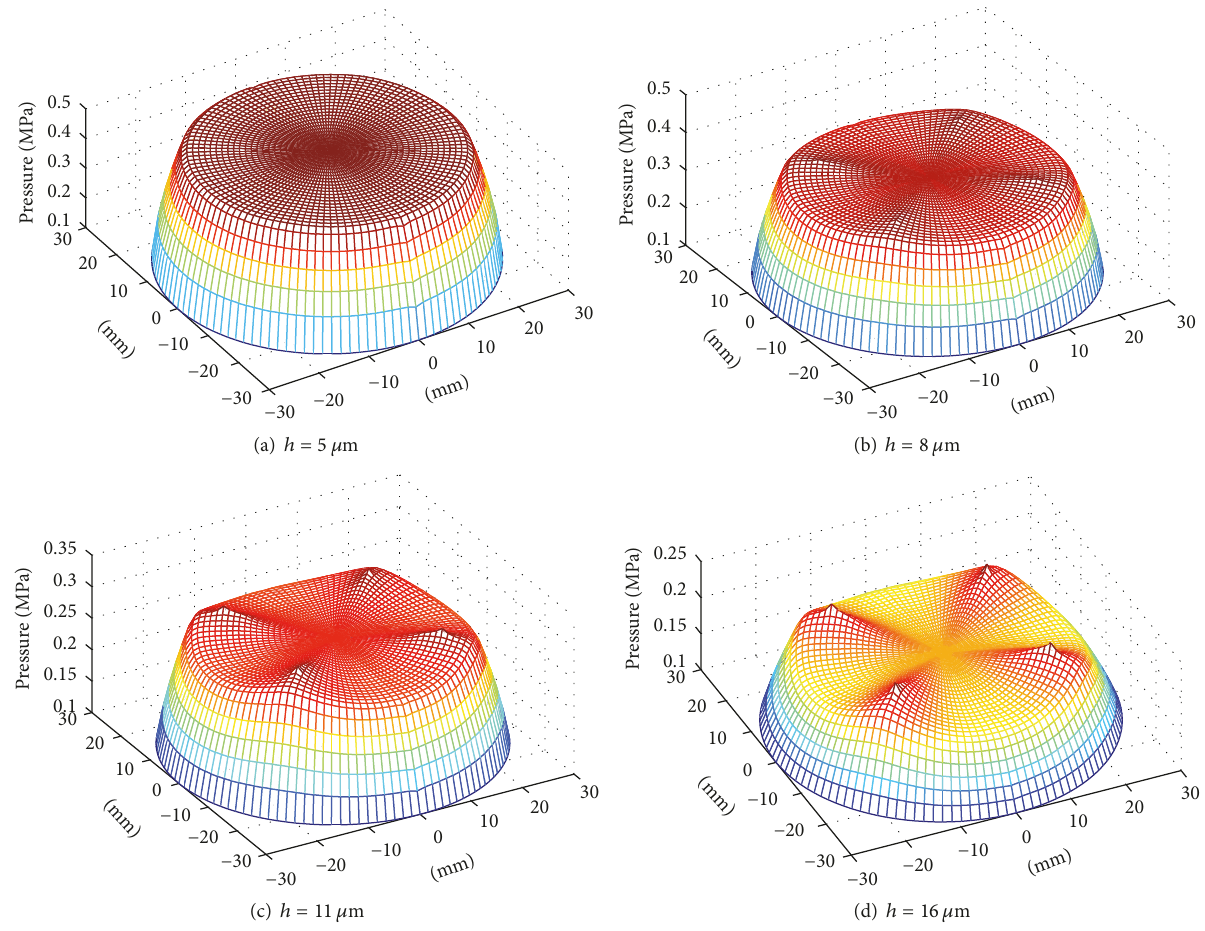
Figure 7: Pressure distribution of aerostatic bearing with